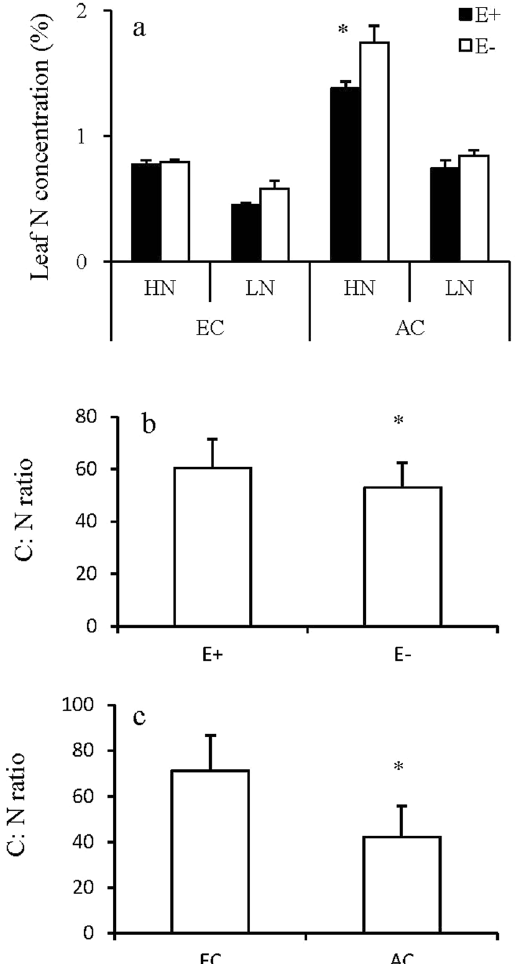
Figure 3. Leaf N concentration of endophyte-infected (E + ) or uninfected (E − ) Festuca arundinacea under different CO 2 and nitrogen levels ( a ). Leaf C:N ratio of Festuca arundinacea under different endophyte ( b ) and CO 2 treatments ( c ). * Meant significant difference at 0.05